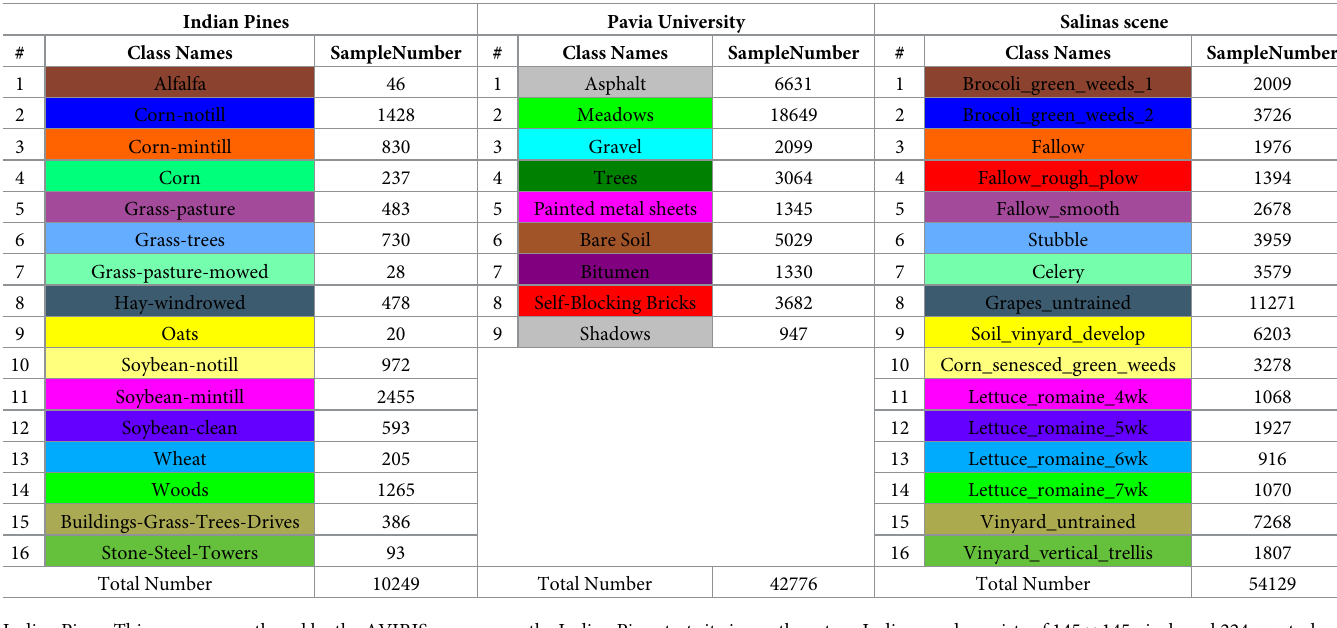
Table 1. Number of samples in the Indian Pines, Pavia University, and Salinas scene